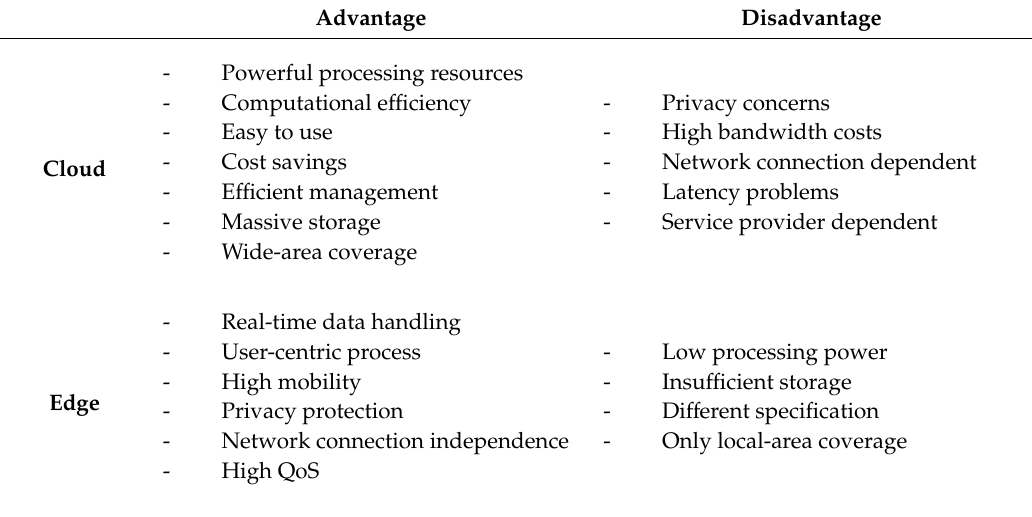
Table 1. Advantage vs. disadvantage of cloud and edge platforms in terms of data analysis